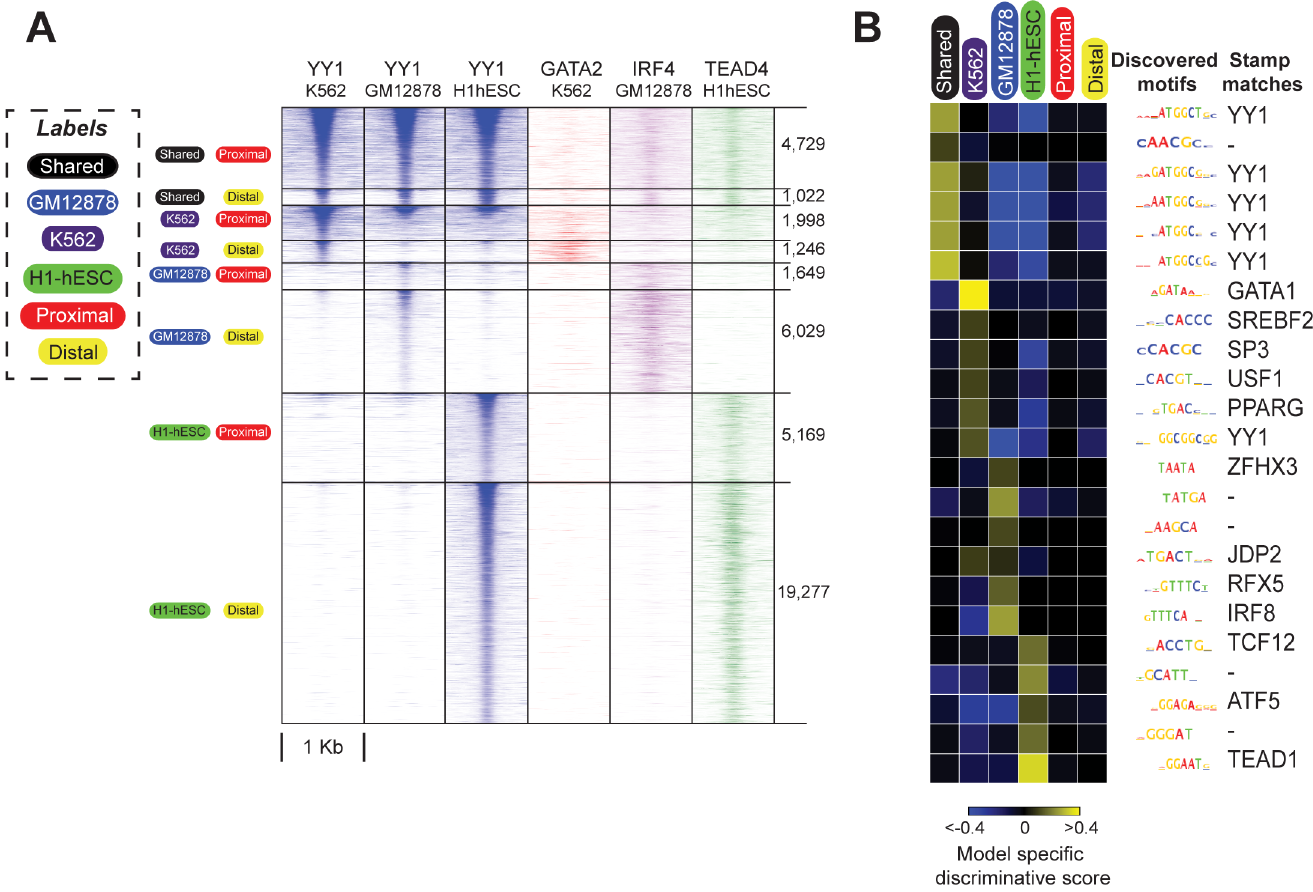
Fig 4. SeqUnwinder analysis of sequence featuresat multi-condition TF binding sites for ENCODE YY1 datasets. (A) Heatmaps showingthe YY1 ChIP-seq reads at curated YY1 bindingsites, stratified based on bindingacross cell-linesand distancefrom annotated mRNA TSS. The order of subclasses is: Shared and Proximal, Shared and Distal, K562 and Proximal, K562 and Distal, GM12878 and Proximal, GM12878 and Distal, H1-hESC and Proximal, and H1-hESC and Distal. (B) De novo motifs and corresponding label-specificscores identified using SeqUnwinder at events definedin A). For consistency across figures, we fix the color saturation values to -0.4 and 0.4.